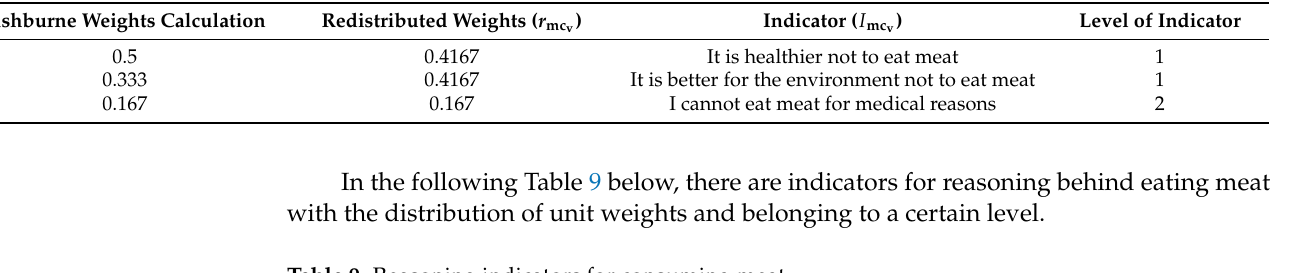
Table 9. Reasoning indicators for consuming